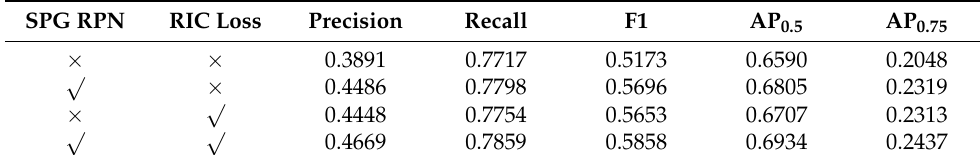
Table 3. Influence of each component in the proposed method.